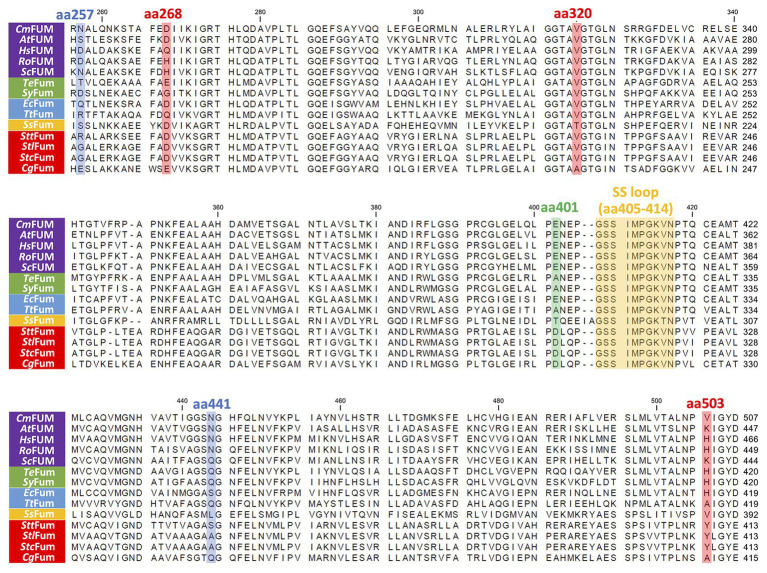
Amino acid sequence comparison of biochemically characterized Class ІІ Fums. Sequences of 14 Class ІІ Fums were obtained from GenBank and aligned using CLC Sequence Viewer ver. 8.0. The blue squares represent amino acid residues equivalent to position 257 and 441 of CmFUM which contribute to the activity of Class ІІ Fum from S. coelicolor (Lin et al., 2007). The green square represents an amino acid residue equivalent to position 401 of CmFUM which contributes to the activity of Class ІІ Fum from Synechocystis 6803 (Katayama et al., 2019). The red squares represent amino acid residues equivalent to position 268, 320, and 503 of CmFUM which contribute to the thermostability of Class ІІ Fum from C. glutamicum (Lin et al., 2018). The yellow square represents a loop region containing the sequence GSSxxPxKxN (called a SS loop) which contributes to substrate binding and catalytic activity (Puthan Veetil et al., 2012). AtFUM: Class ІІ Fum from A. thaliana, HsFUM: Class ІІ Fum from H. sapience, RoFUM: Class ІІ Fum from R. oryzae, ScFUM: Class ІІ Fum from S. cerevisiae, SyFum: Class ІІ Fum from Synechocystis 6803, EcFum: Class ІІ Fum from E. coli, TtFum: Class ІІ Fum from T. thermophilus, SsFum: Class ІІ Fum from S. solfataricus, SttFum: Class ІІ Fum from S. thermovulgaris, StlFum: Class ІІ Fum from S. lividans, StcFum: Class ІІ Fum from S. coelicolor, CgFum: Class ІІ Fum from C. glutamicum.